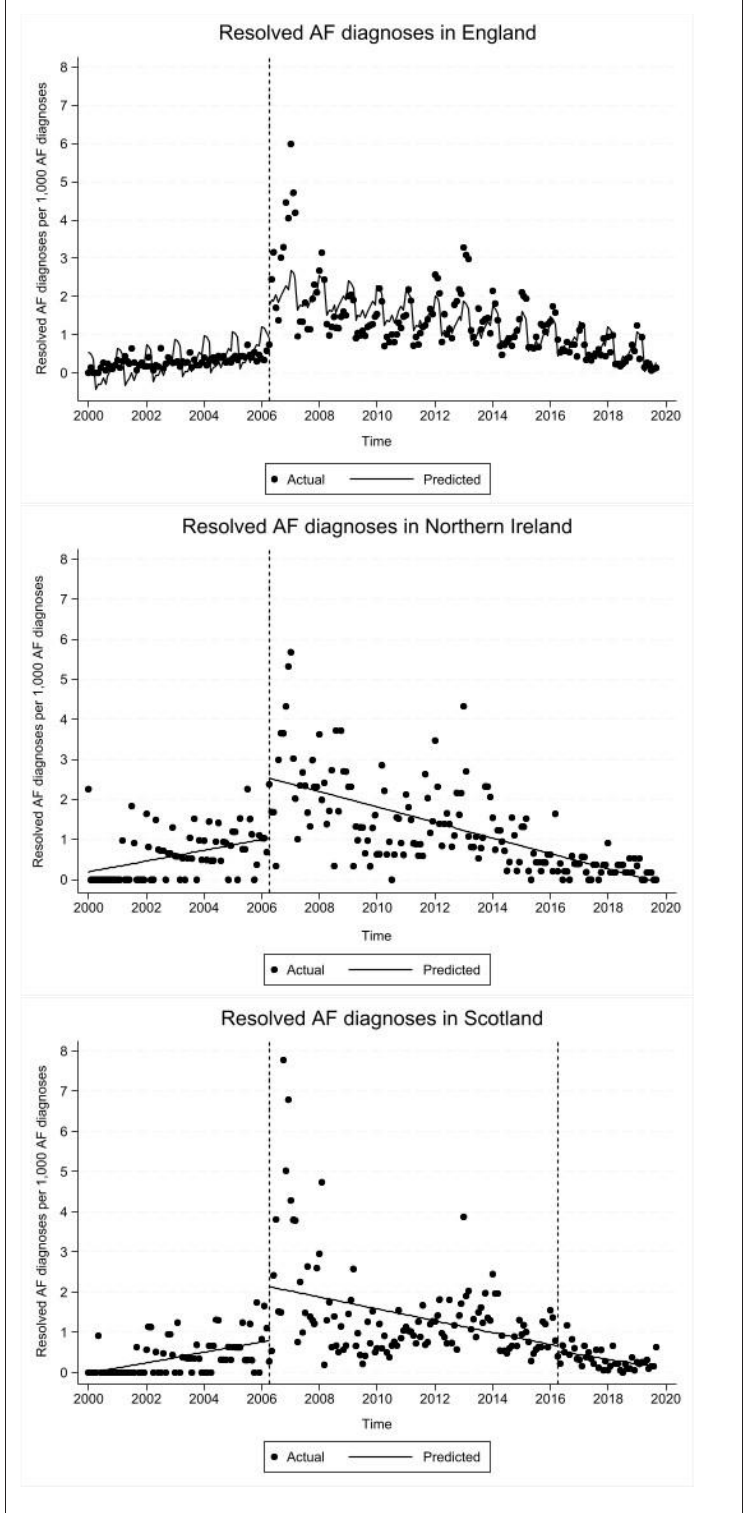
Figure 1 Interrupted time- series model results with dashed lines indicating introduction of the Quality and Outcomes Framework in April 2006 and its removal in April 2016 in Scotland. Dots represent monthly resolved atrial fibrillation (AF) diagnoses per 1000 AF diagnoses, lines represent model prediction of resolved AF